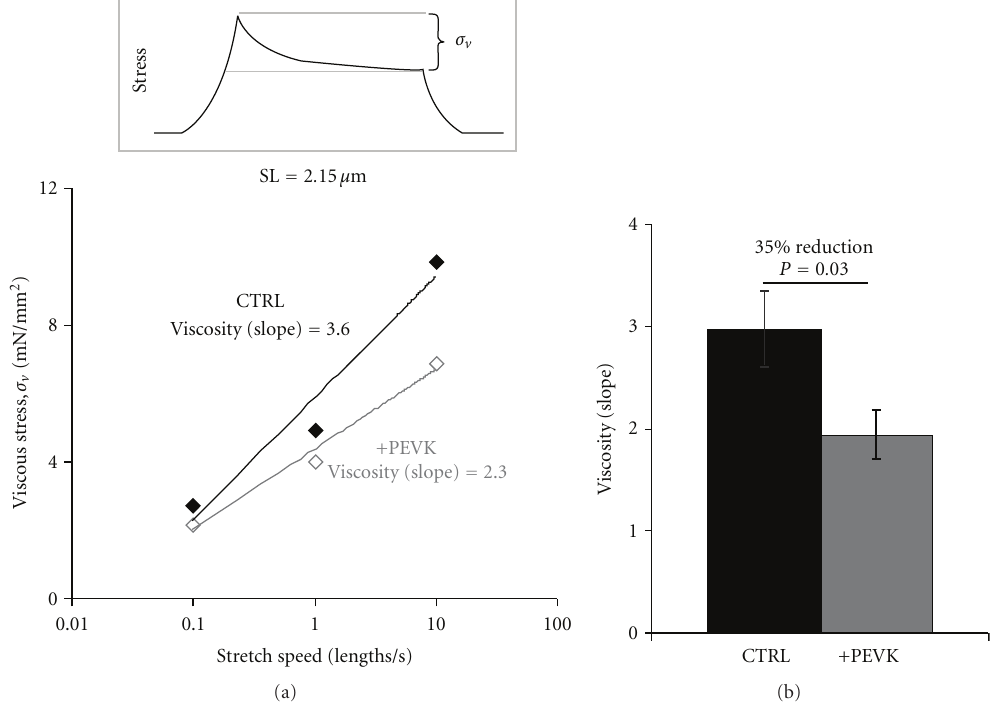
Figure 2: Measurement of viscosity from stress relaxation data in pig tissue. (a) Example viscosity data derived from stress relaxation in a fiber untreated (CTRL, black) and in presence of recombinant PEVK protein (+PEVK, gray). Inset: schematic of explaining how viscous stress ( σ v ) was determined. (b) Exogenously added PEVK reduces the viscosity (slope) by 35%. See text for